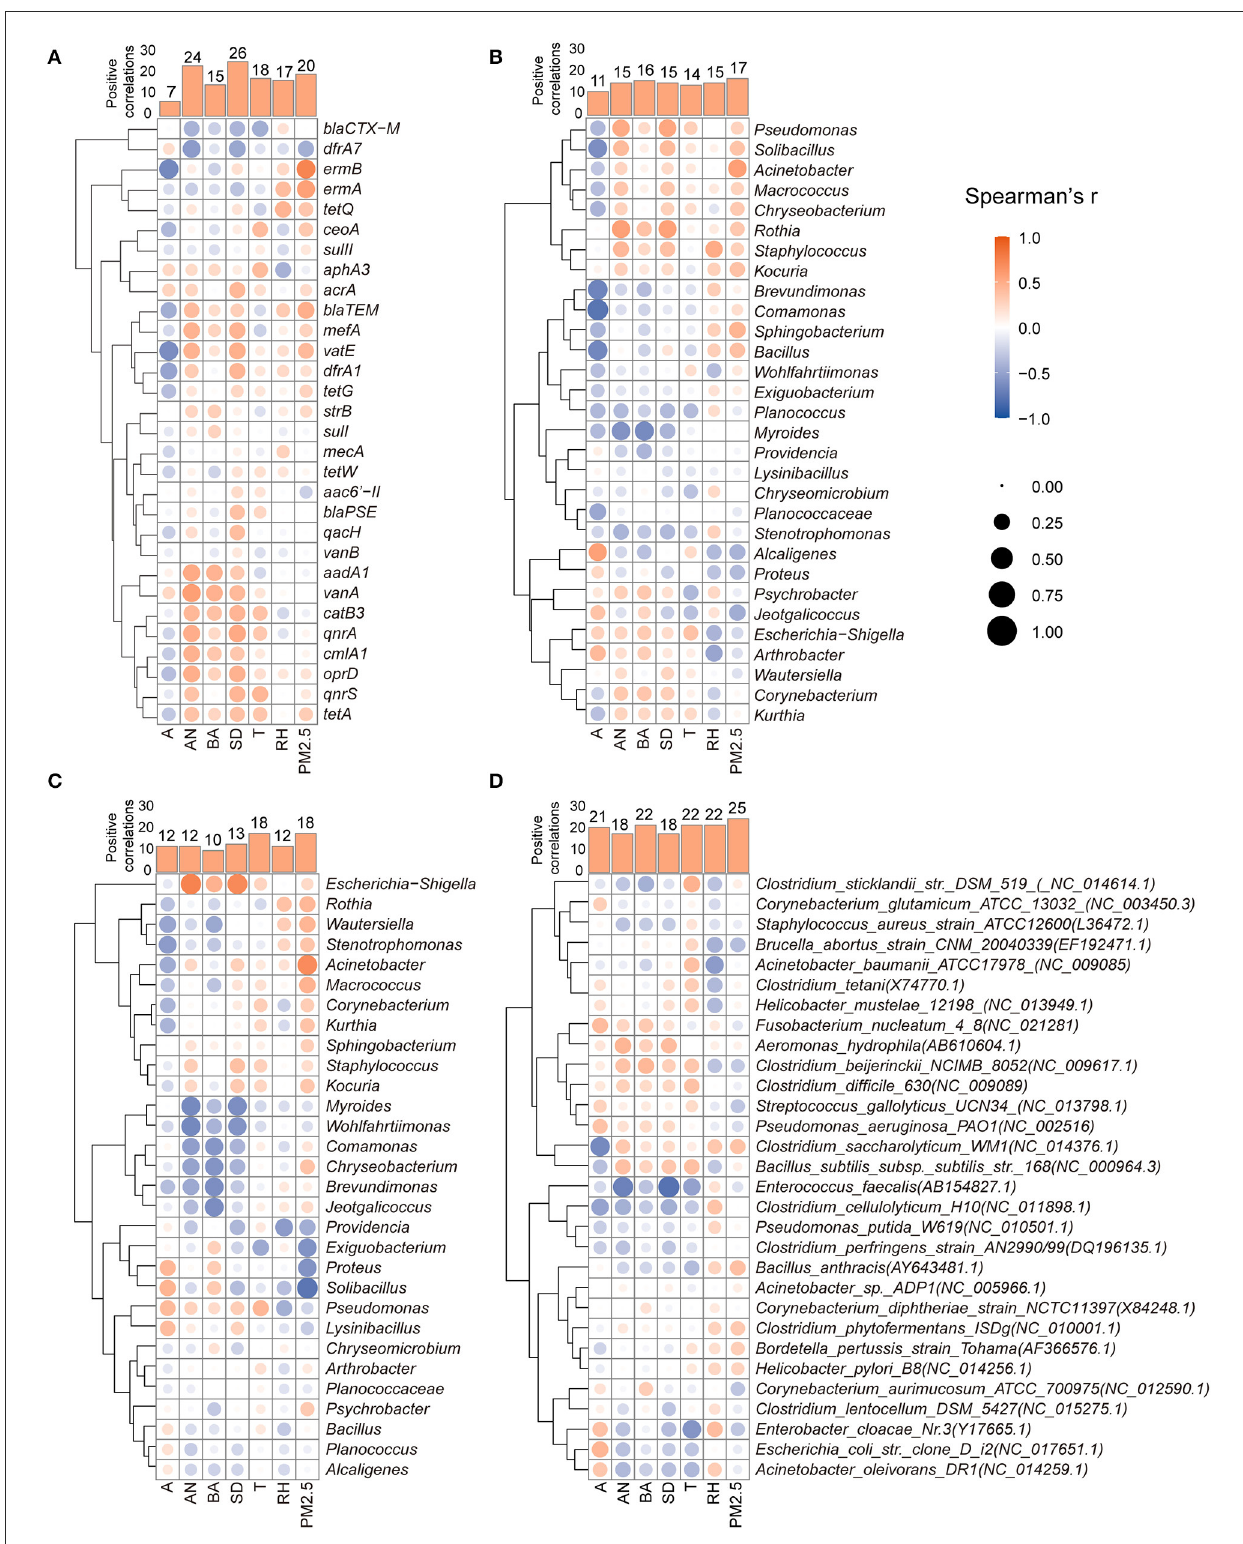
FIGURE6 Factors associated with the aerosolization behavior of specific ARGs (A) , erythromycin-resistant bacterial genera (B) , tetracycline-resistant bacterial genera (C) , and human pathogenic bacteria (D) . (A, Age; AN, animal number; BA, breeding area; SD, stocking density; T, temperature; RH, relative humidity; PM2.5, PM2.5 mass